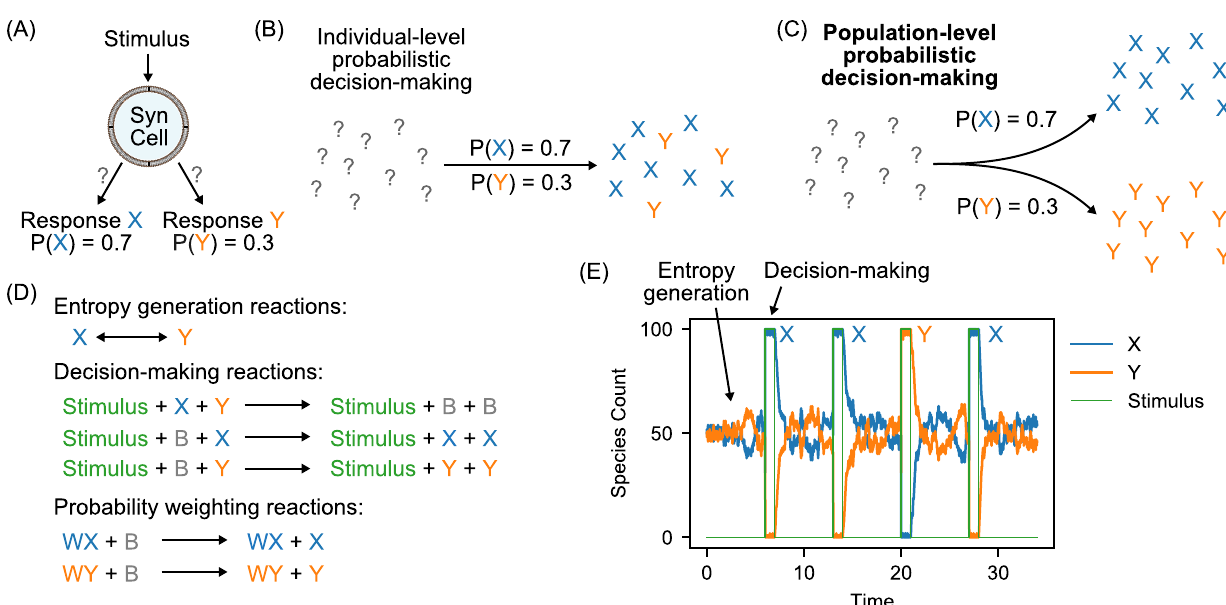
Fig 1. Probabilistic decision-making in stochastic chemical reaction networks. (A) Example application of probabilistic decision-making to drive the actions of a synthetic cell in response to external stimuli, via the random choice between one or more responses with particular probabilities. (B) Randomized decision-making at the level of individual chemical species produces roughly deterministic results when considered at the population scale, with decision molecules generated in proportion to the overall probabilities. (C) Here we propose a system for probabilistic decision-making at the population level, in which the entire population makes a coordinated transition into one decision state or the other based on the decision probabilities. (D) Basic design for probabilistic decision-making system. A simple reversible reaction between the X and Y species introduces entropy into the system. Then, when the Stimulus species is introduced, the approximate majority reaction system is activated, which converts all of the decision species into whichever happens to be in the majority when the stimulus is activated. This produces a randomized decision at the population level. To enable tuning of decision probabilities, additional weight species WX and WY can also recruit the “undecided” species B from the approximate majority reaction system to the corresponding decision species. The forward and backward rate constants for the entropy generation reactions are both kNoise = 1. The rate constants for the decision-making reactions are kAM = 1. The rate constants for the probability weighting reactions are kBias = 30. (E) Example stochastic simulation showing several sequence decisions between X and Y activated by the Stimulus species. In this example, the counts of the weighting species are WX ¼ 60 and WY ¼ 40 , which translates to decision probabilities of P ð X Þ ¼ 0 : 7 and P ð Y Þ ¼ 0 : 3 (see Fig 2 for calculations that derive this